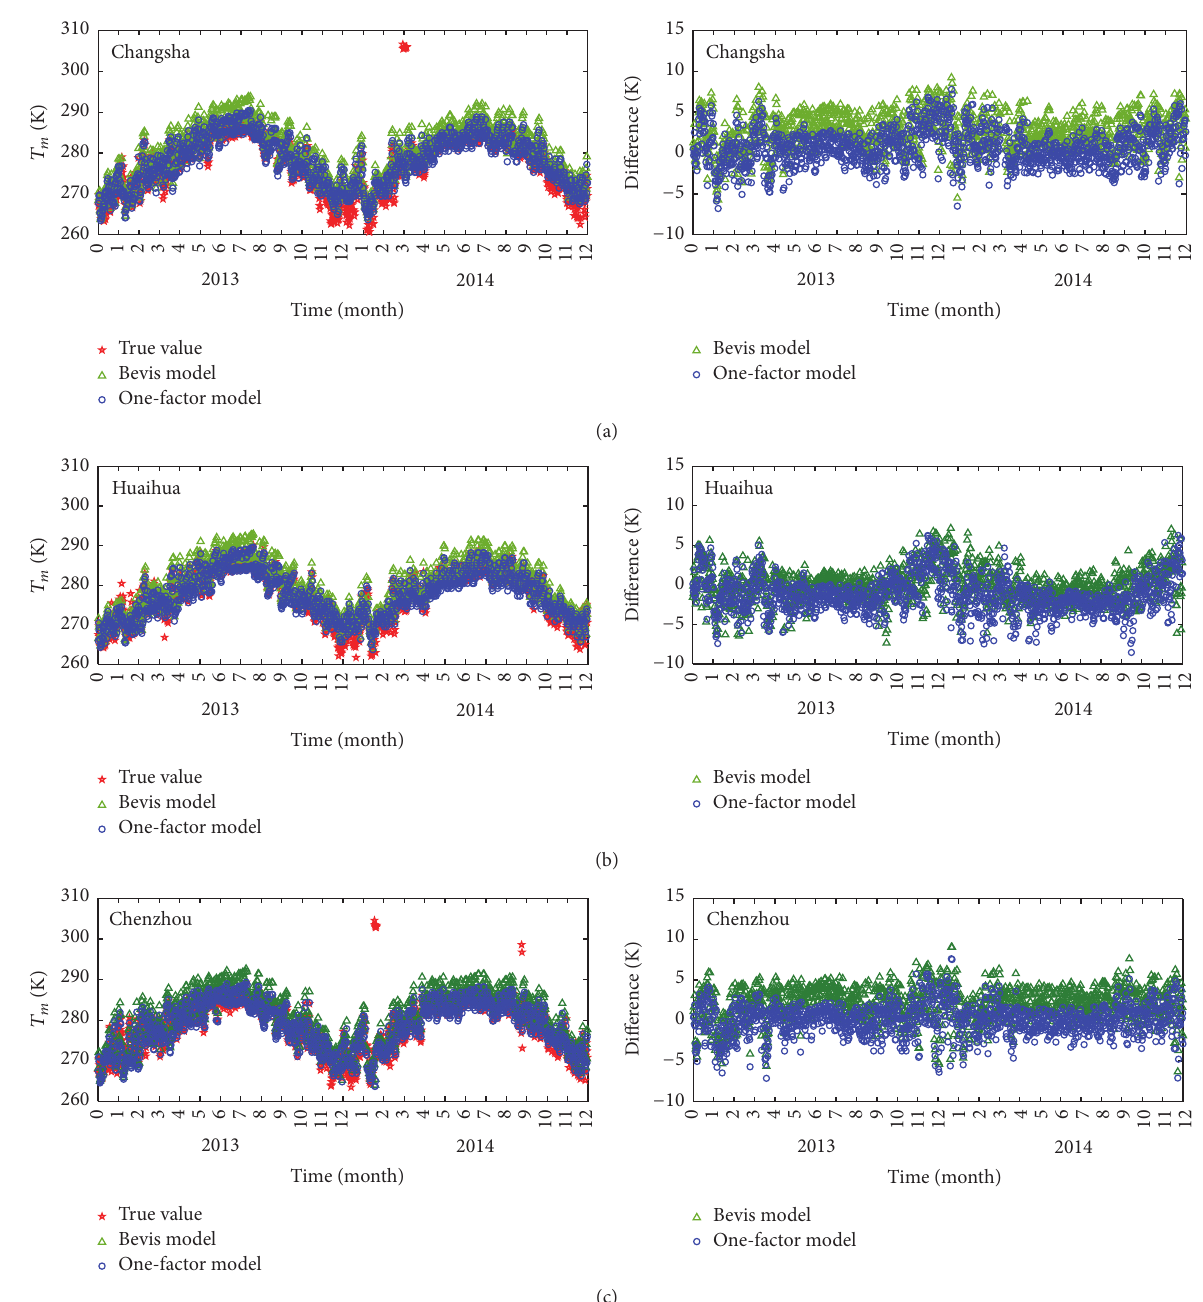
Figure 4: Comparison of the three 𝑇 𝑚 time series (left) and the differences of the BTM and RTM results from the 𝑇 𝑚 truth (right) at the three stations (a) Changsha, (b) Huaihua, and (c)